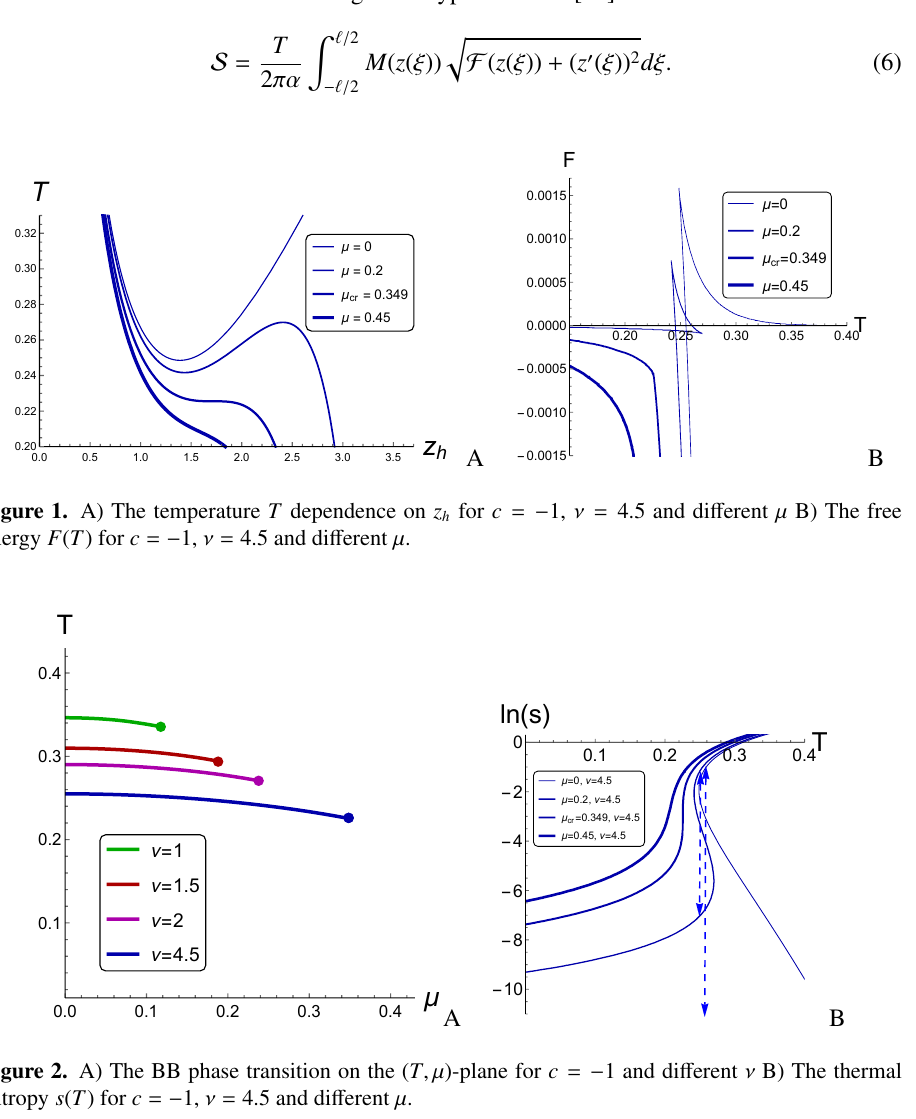
Figure 2. A) The BB phase transition on the ( T ,µ )-plane for c = entropy s ( T ) for c = 1, ν = 4 . 5 and di ff erent µ −